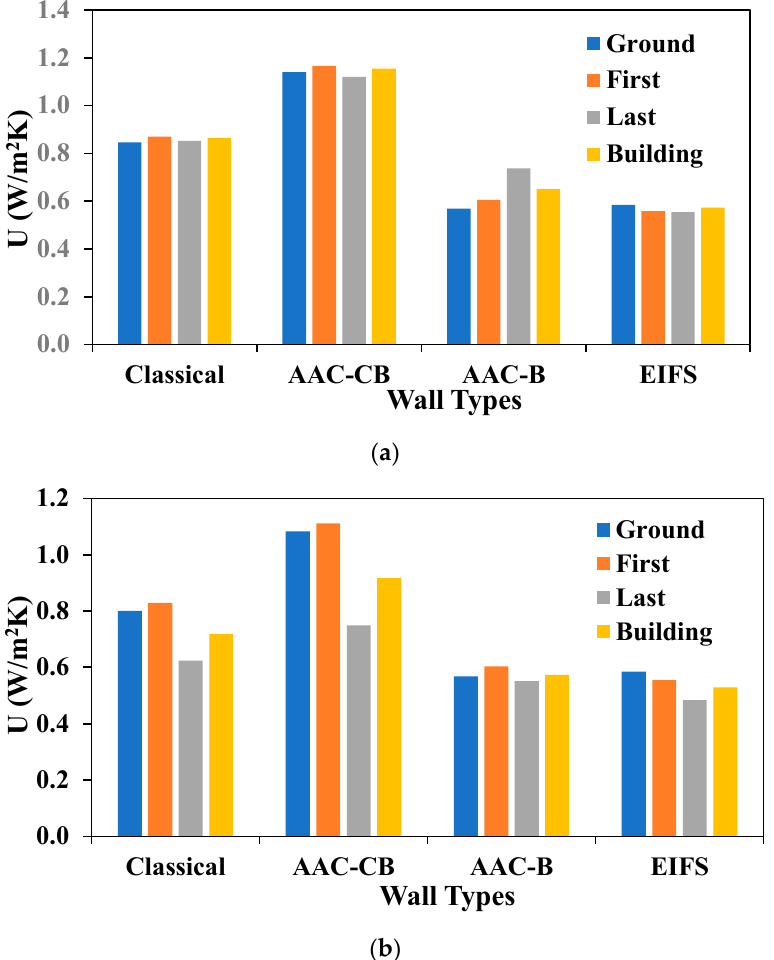
Figure 10. ( a ) Overall heat transfer coefficient of the small room for various floors and the building envelope; ( b ) Overall heat transfer coefficient of the large building for various floors and the building envelope.